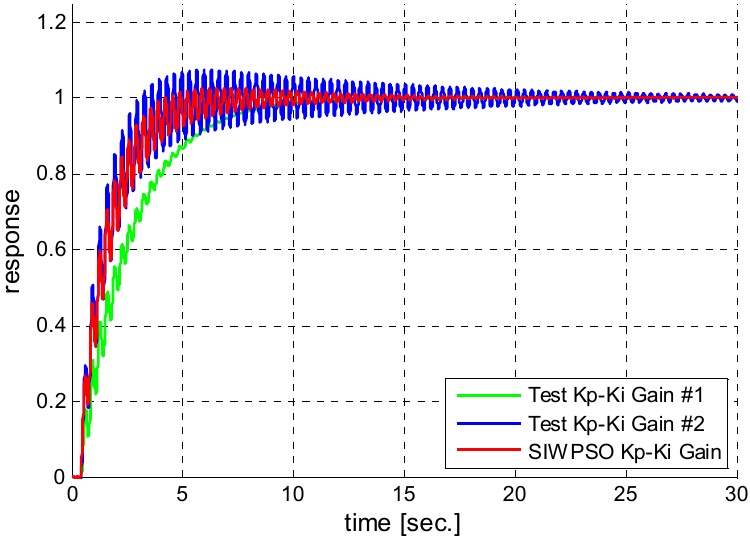
Figure 14. The performance verification of the wind turbines generator system.